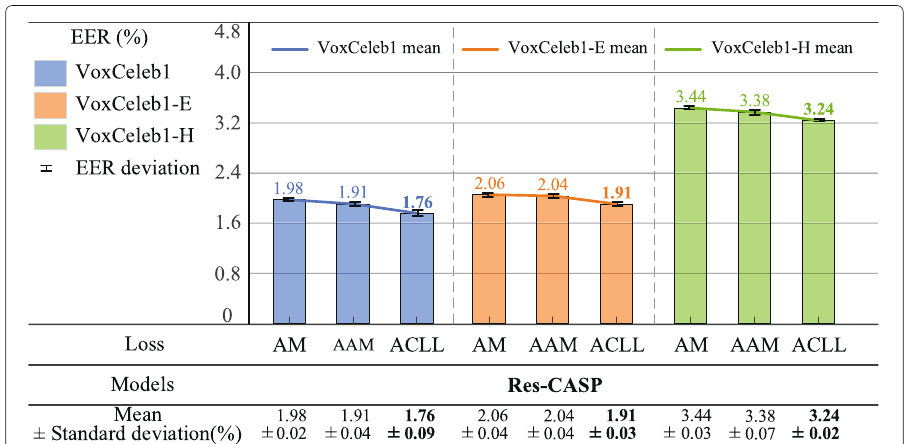
Fig. 6 Text-independent speaker recognition based on AM, AAM, and ACLL, where AM, AAM, and ACLL were used as the loss function, respectively. The EER experimental results of text-independent speaker recognition on the Res-CASP